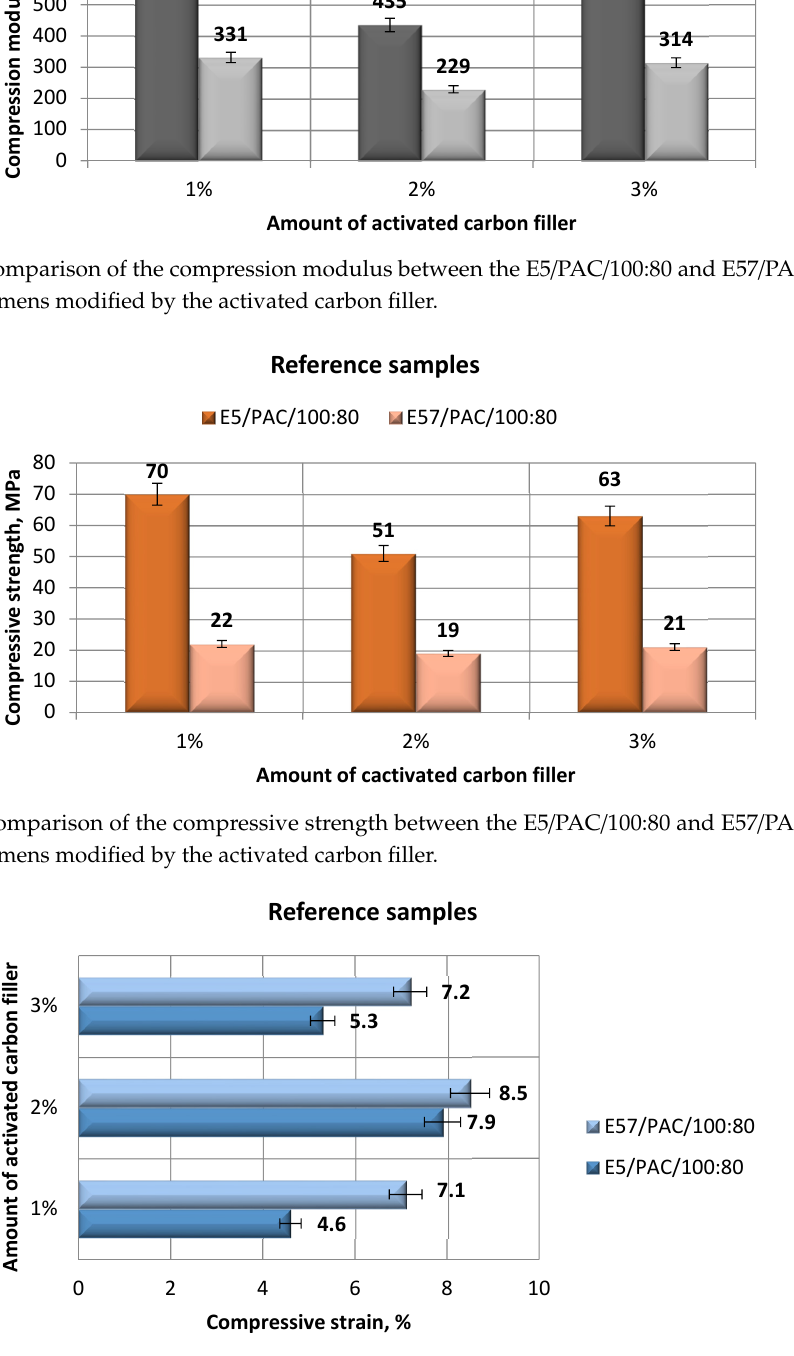
Figure 9. Comparison of the compressive strain between the E5/PAC/100:80 and E57/PAC/100:80 epoxy specimens modified by the activated carbon filler.